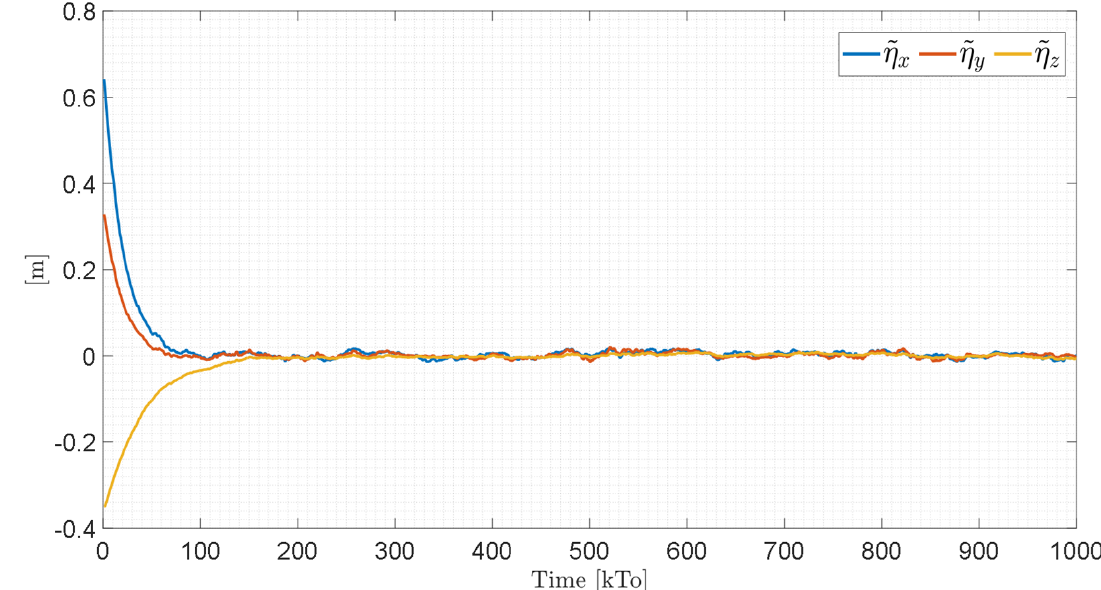
(cid:0) (cid:1) . (cid:101) η x , (cid:101) η y , (cid:101) η z